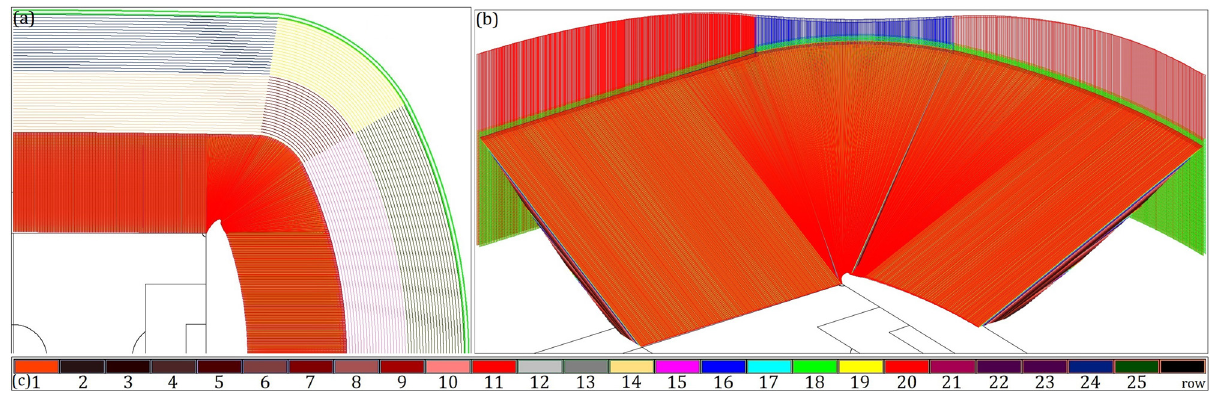
Figure 11: Lines ILSF for the focus point FO : ( a ) in the stands BAI, BBI, AAI, ABI, and CI ( for n rows ) , ( b ) in the stands BA, BB, AA, AB, and C ( for R n m k = + + rows ) , and ( c ) color palette.